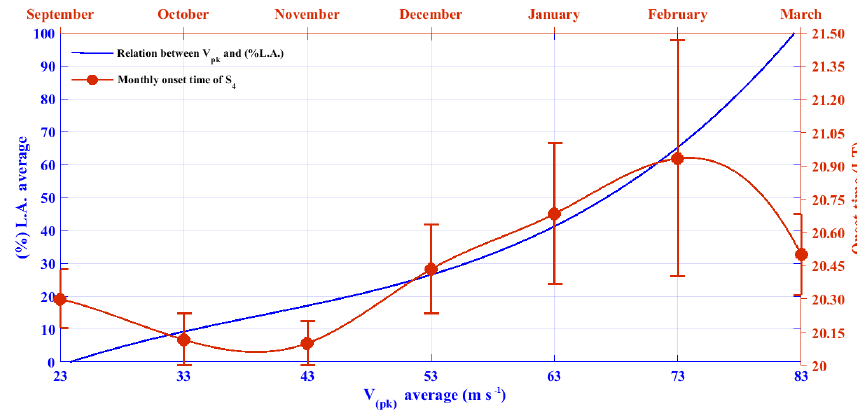
Figure 8. Approximation proposed for maximum percentage of links affected according to V pk values (blue line) and the monthly time variability of the S 4 activity onset (red